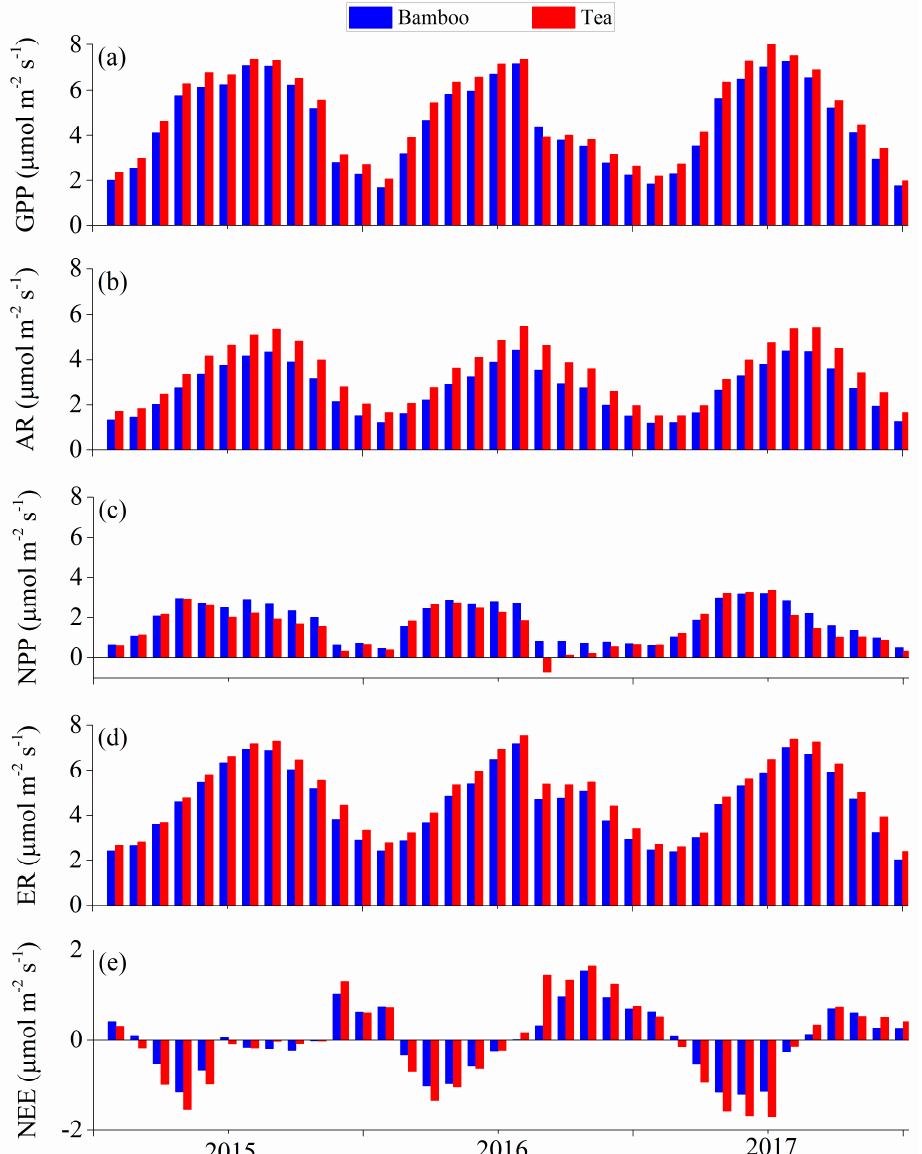
Figure 10. Modeled monthly carbon fluxes at the two study plots. ( a ) AR, autotrophic respiration; ( b ) ER, ecosystem respiration; ( c ) GPP, gross primary production; ( d ) NEE, net ecosystem exchange; ( e ) NPP, net primary production. The monthly NEE with an absolute value greater than 0.50 µmol m − 2 s − 1 was defined as CO 2 emissions or absorption in this study. CO 2 absorption mainly occurred within (2015) or around (2016